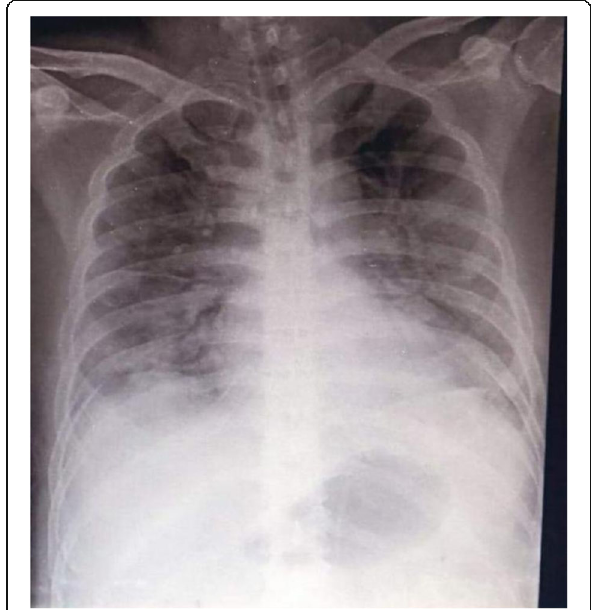
Fig. 5 Posteroanterior chest radiograph of patient 2, 30 January 2020 (illness day 13). Endotracheal tube in situ approximately 2 cm above the carina. There is worsening of the previously noted